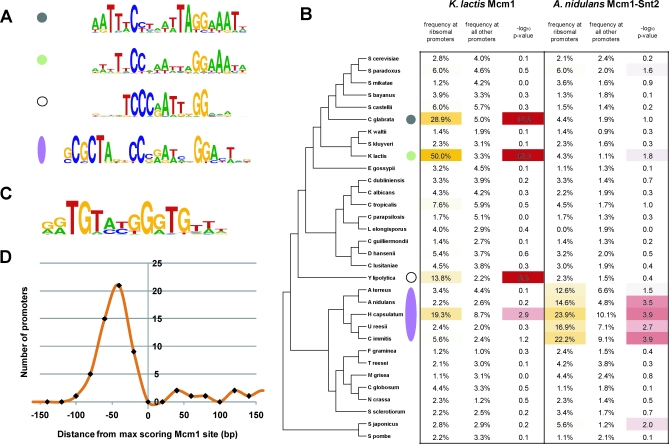
Evolution of Mcm1 Binding Sites at Ribosomal Genes in the Ascomycete Lineage(A and B) Convergent evolution of Mcm1 motifs at ribosomal genes. (A) Four Mcm1-like cis-regulatory motifs discovered in a MEME search of the ribosomal gene promoters of 32 fully-sequenced ascomycete genomes. The motifs were discovered in the species indicated by the colored circles and oval in (B). The Mcm1-like motif of the A. nidulans branch has a tandem cofactor motif that is nearly identical to that derived from Snt2 ChIP-Chip experiments in S. cerevisiae [43]; we therefore predict that the Snt2 orthologs of the A. nidulans lineage are the Mcm1 cofactors at the ribosomal genes of this lineage. (B) The Mcm1 motifs from K. lactis (green circle) and the A. nidulans lineage (lavender oval) were used to score ribosomal promoters across the ascomycete lineage and thus to verify that presence of the Mcm1 motifs is limited to the four lineages in which Mcm1-like motifs were found de novo by MEME. The significance of motif enrichment at the ribosomal promoters of each species was determined by comparison to genome-wide background frequencies of occurrence using the binomial distribution. See Text S1 for description of the ascomycete phylogeny reconstruction [24,67].(C) An additional motif similar to that recognized by Rap1 in S. cerevisiae was discovered in the MEME search of K. lactis ribosomal promoters.(D) In K. lactis, the positioning of Rap1-like motif instances is constrained relative to Mcm1 motif instances.